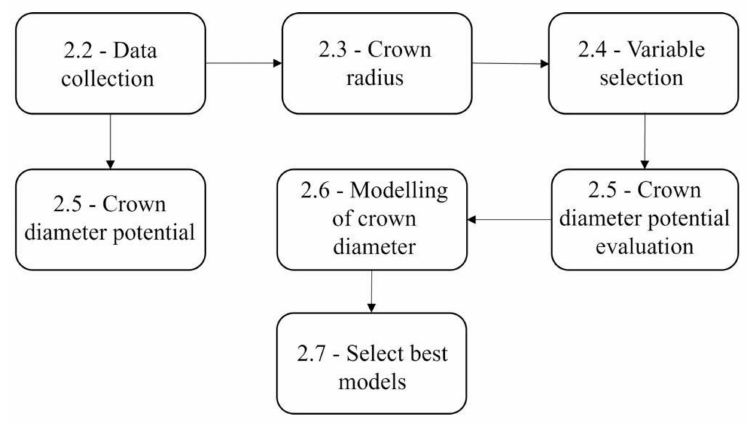
Figure 4. Methodological